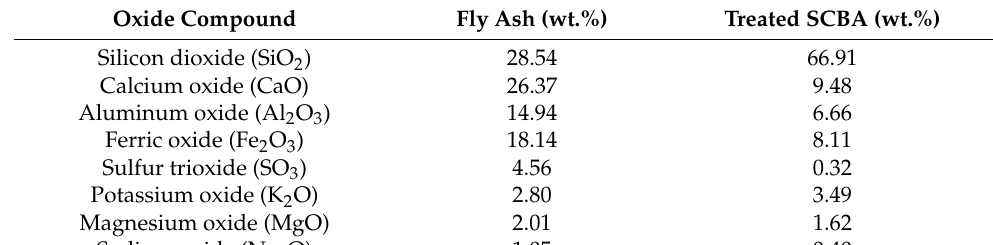
Table 1. Chemical composition of as-received FA and treated SCBA.